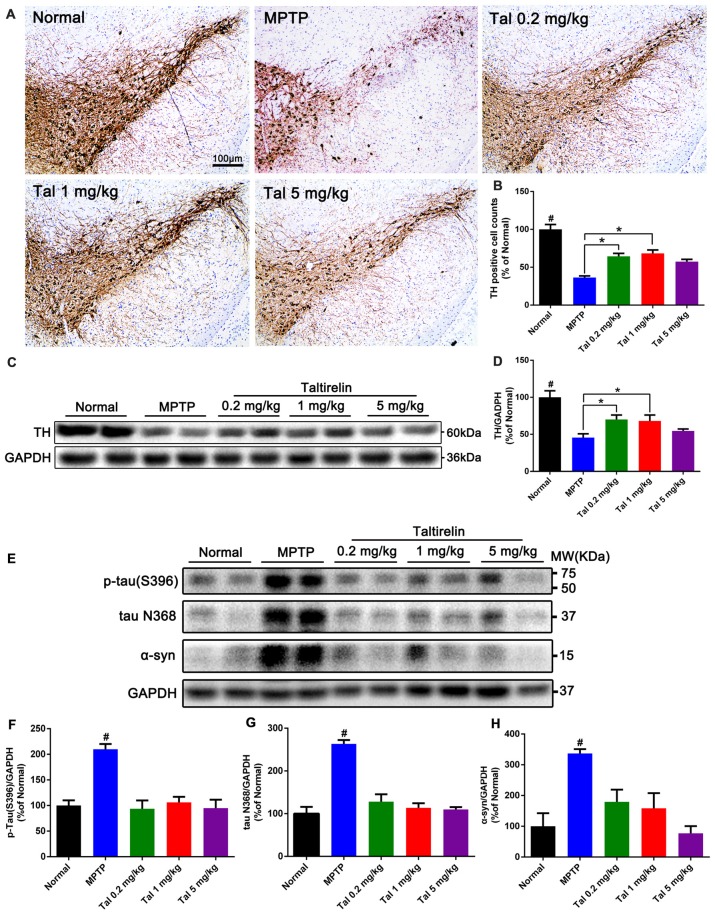
Taltirelin protected dopaminergic neurons and reduced PD-related pathologies in MPTP-induced PD mice model. (A) Tyrosine hydroxylase (TH) immunostaining of the substantia nigra (SN) of mice treated with MPTP (30 mg/kg, i.p.), with or without Taltirelin (0.2 and 1 mg/kg). (B) Analysis of TH positive cells counts in each group. (C) Western blot analysis showed the levels of TH in the striatum of each group. (D) Quantification of the levels of TH. (E) WB showed the levels of p-tau (S396), tau N368 and α-synuclein in the SN of each group. (F–H) Quantification of WB of p-tau (S396), tau N368 or α-synuclein vs. GAPDH. #p < 0.05 vs. other groups; *p < 0.05. N = 3. Error bars represent SEM.